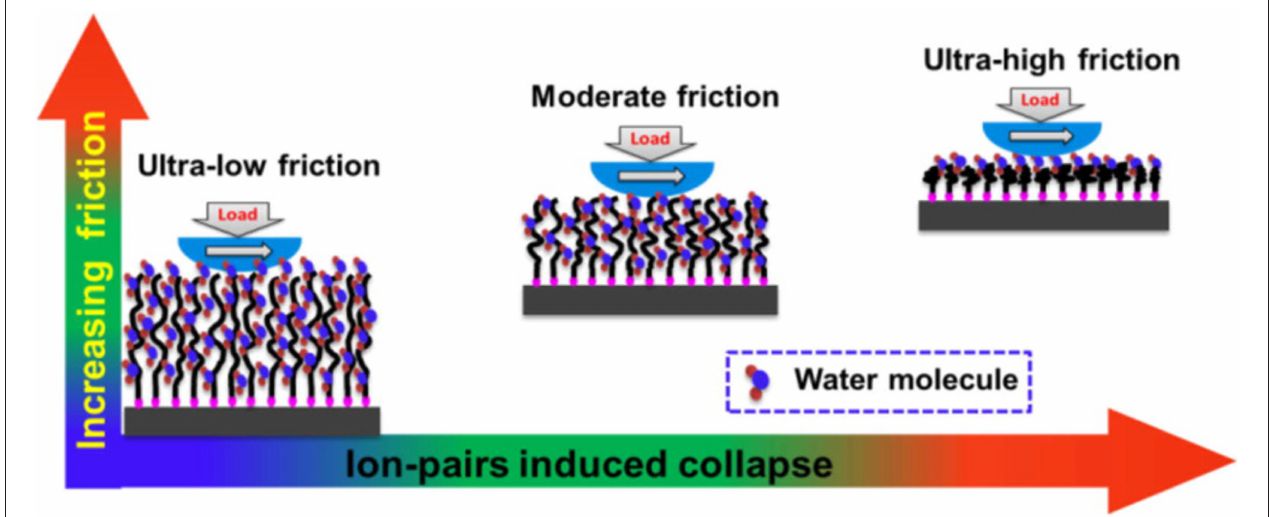
FIGURE 4 | Schematic of the dependence of friction on the stretching of polyelctrolyte brushes. Reprinted with permission from Wei et al. (2013). Copyright 2013 American Chemical Society. Externally applied fields and/or changes in the electrolyte counterions or pH can modify the brush configuration because the brushes are electrically charged. Water molecules fully penetrate the brushes when they are fully stretched and friction coefficients are ultra-low, of order µ = 10 − 3 . Water molecules are completely expelled from the brushes when they are fully compressed and friction levels are high, of order µ =